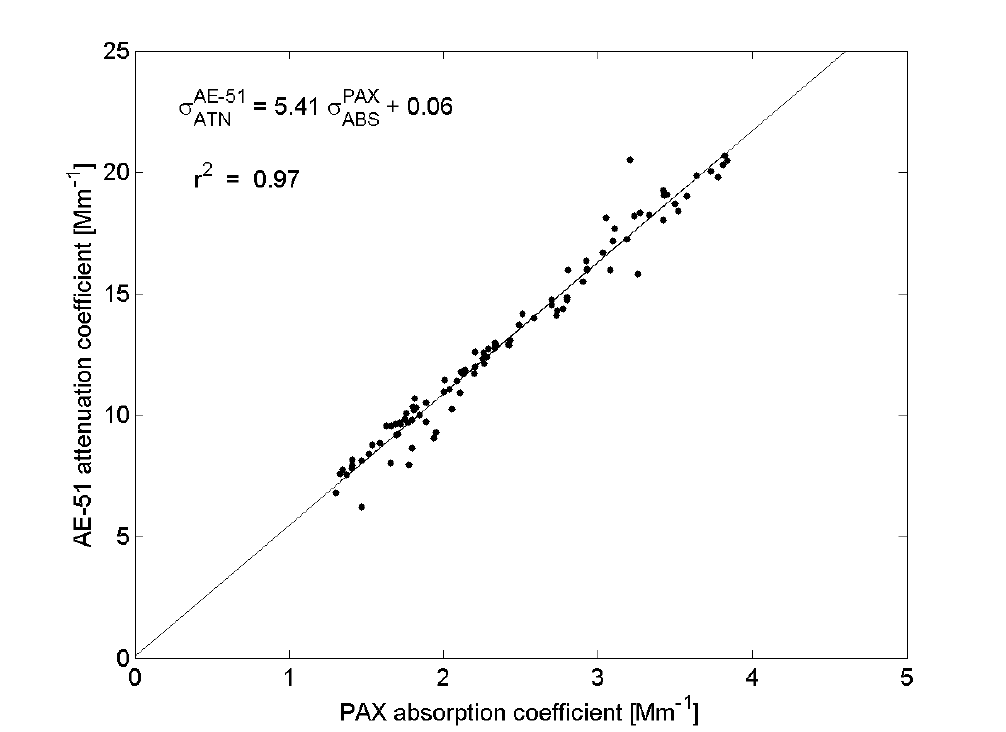
Figure 3. Comparison of AE-51 attenuation coefficient at 880 nm and aerosol absorption coefficient at 870 nm from photoacoustic extinctiometer (PAX) obtained between 29 June and 1 July of 2016. Black dots represent one-hour average data while the solid line is a linear